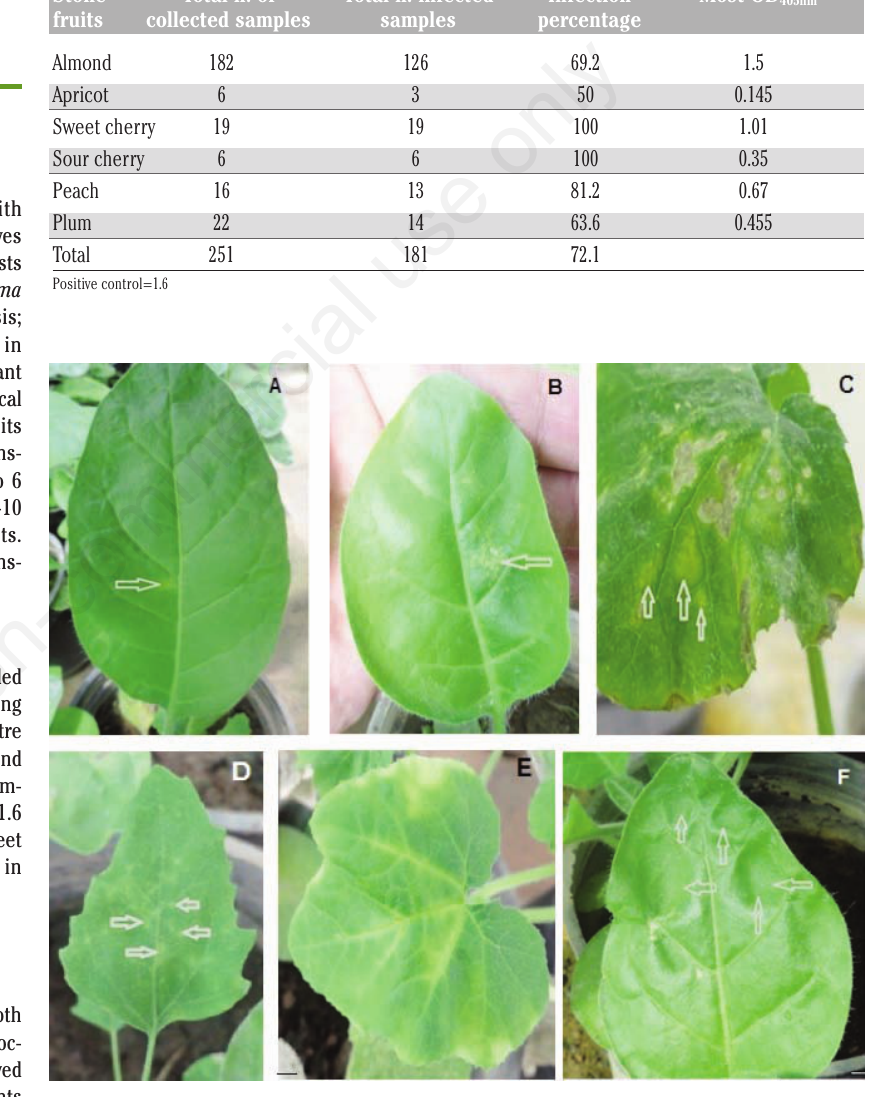
Figure 2. Different symtoms of PDV inoculation to indicator plants. A) Local chlorosis (Arrow) on N. tabacum var.Turkish, B) Local necrosis (Arrow) on N. rustica , C) Mosaic, local chlorosis (Arrows) on C. sativus , D) Local chlorosis (Arrows) on C. album . E) Mosaic, chlorosis and vein yellowing (Arrows) on C. maxima . F) Leaf malformation (Arrows) on N. rustica